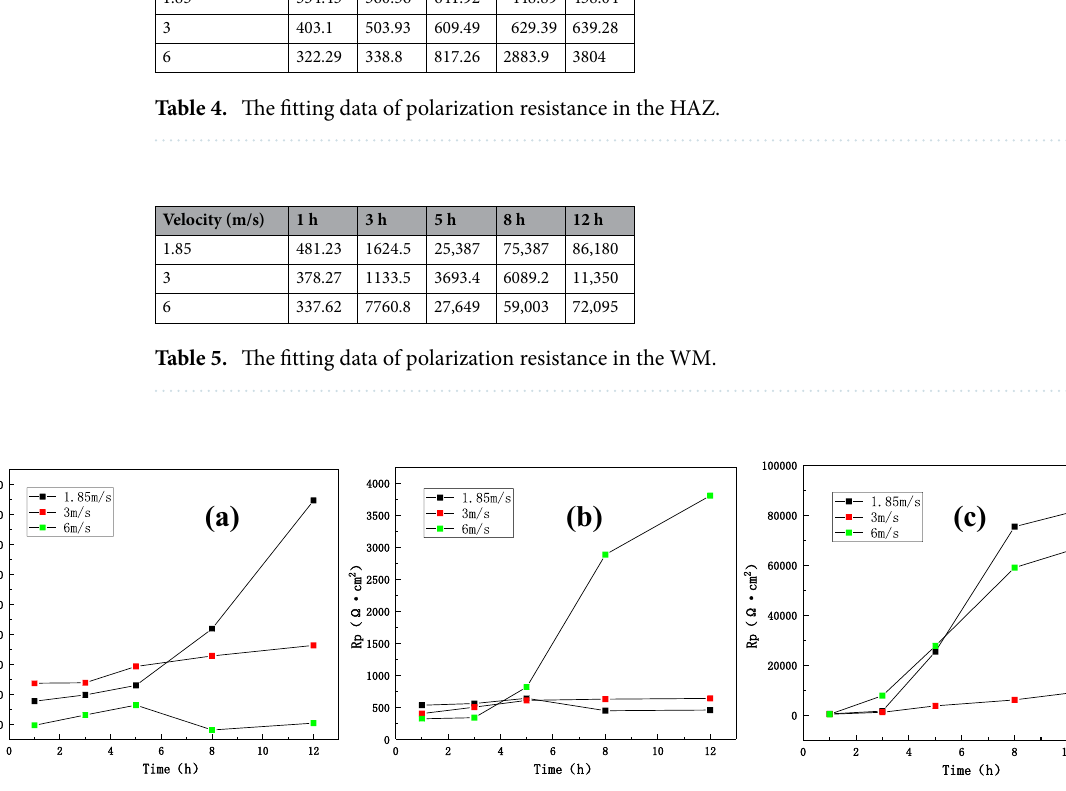
Figure 13. LPR comparison of three sections of B10 alloy welded joint at different flow rates: ( a ) BM, ( b ) HAZ, and ( c )